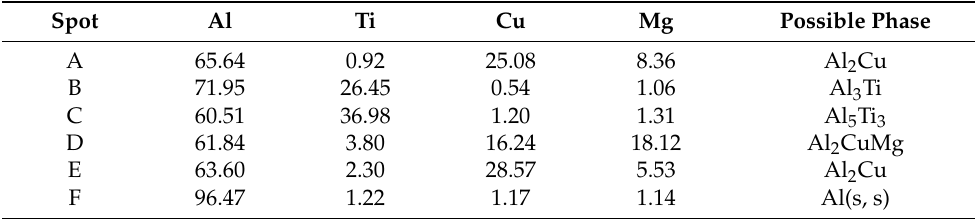
Table 1. EDS analysis of the selected spots in Figure 2 (at. %).